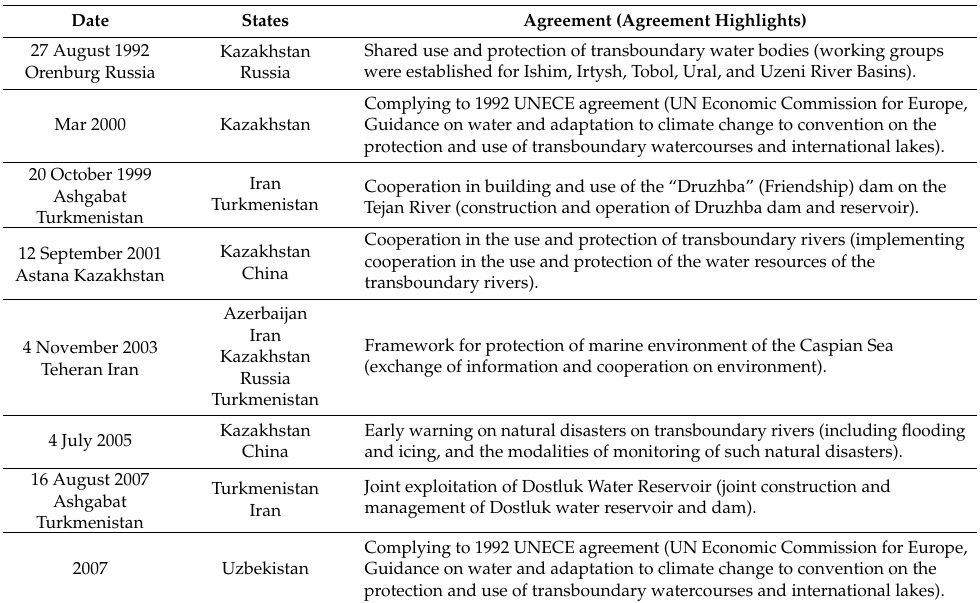
Table 4. Select water related agreements involving Central Asian states and other countries (after Volovik [68], Ziganshina [74], and Berdiev